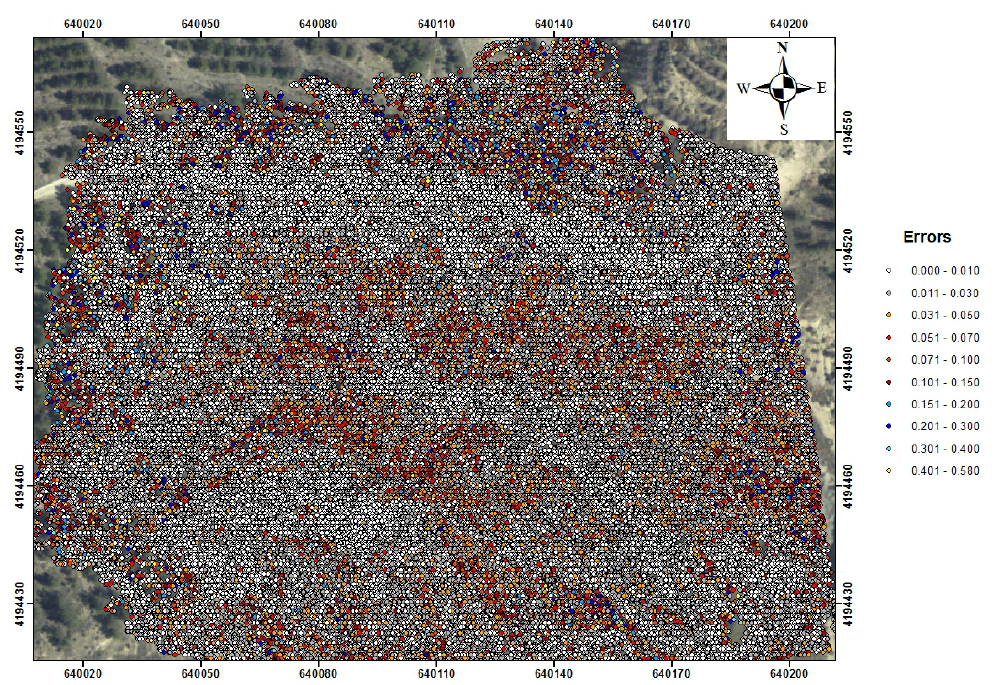
Figure 9. Example of point cloud uncertainty estimated by cross-validation on the gully